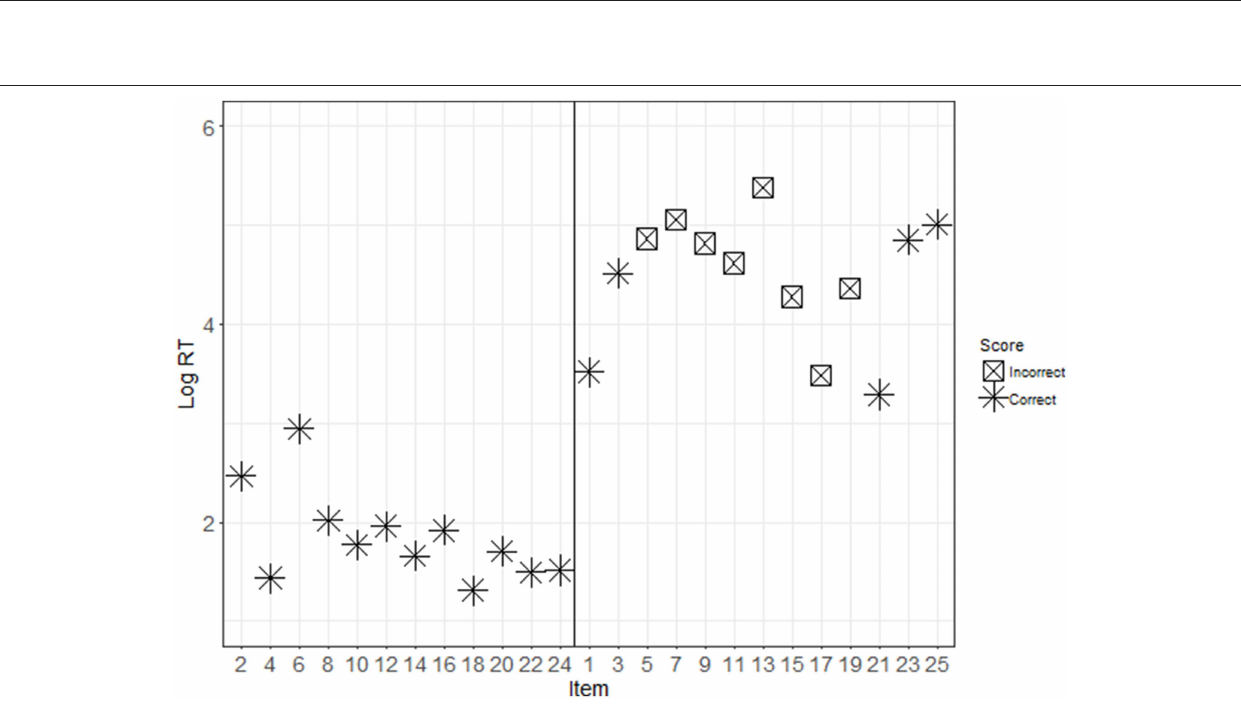
FIGURE 3 | Response patterns for an ItemOnly participant. This figure shows the item scores (see marker shape) and log RTs (y-axis) for disclosed (even, presented on the left) and undisclosed (odd, presented on the right) items. Note that for this ItemOnly participant, there is a discernable difference between the response patterns for the disclosed and undisclosed items, such that disclosed items are more likely to be answered correctly and